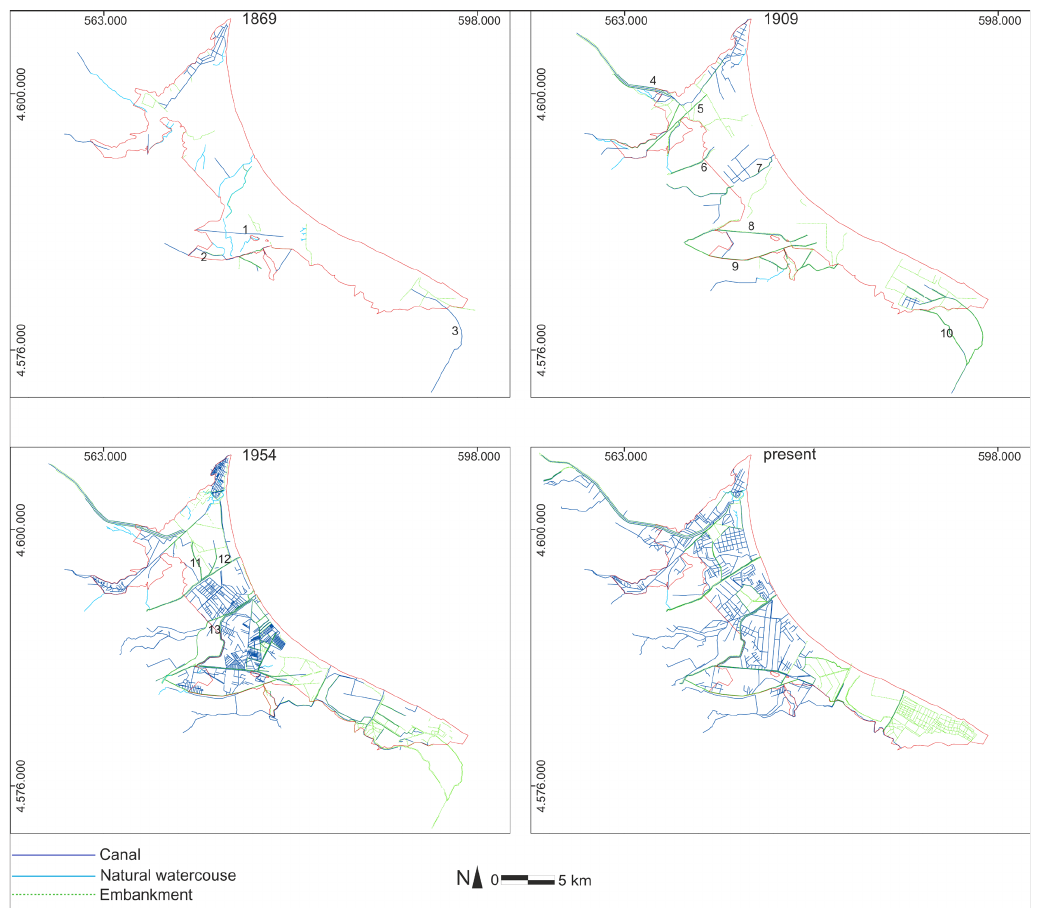
Figure 6. Evolution of the linear landforms functional to the reclamation of the study area in 1869, 1909, 1954, and the present day. The identified linear landforms are classified into four categories: embankments, main channels, natural rivers, and secondary channels.